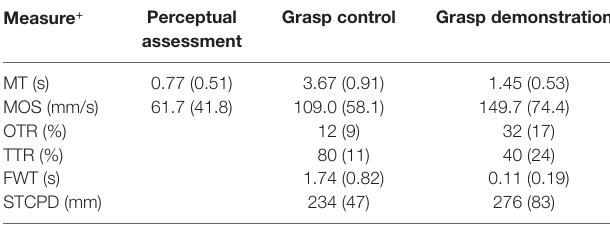
+ MT, movement time; MOS, mean aperture opening speed; OTR, aperture opening time ratio; TTR, aperture transport time ratio; FWT, final waiting time; STCPD, the scaled sagittal tool center point transport distance.